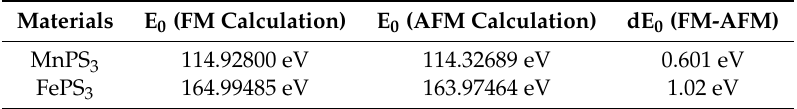
Table 2. Total energy calculations for ferromagnetic (FM) and anti-ferromagnetic (AFM) state and their difference for MnPS 3 and FePS 3